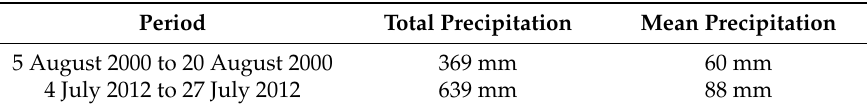
Figure 7. The correlation between the precipitation and the frequency of dry lake bed formation at each of the eight levels of pixels in study area. Table 1. Difference in precipitation when dry lake beds decreased.